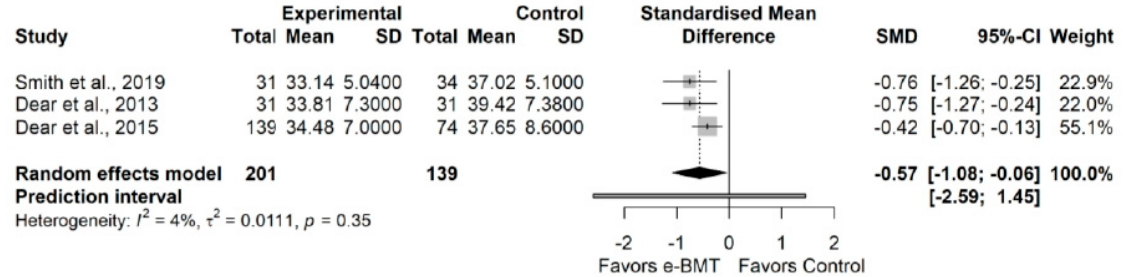
Figure 3. Synthesis forest plot of pain interference variable for online behavioral techniques against usual care or waiting list. The forest plot summarizes the results of included studies (sample size, mean, standard deviation (SD), standardized mean differences (SMDs), and weight). The small boxes with the squares represent the point estimate of the effect size and sample size. The lines on either side of the box represent a 95% confidence interval (CI).